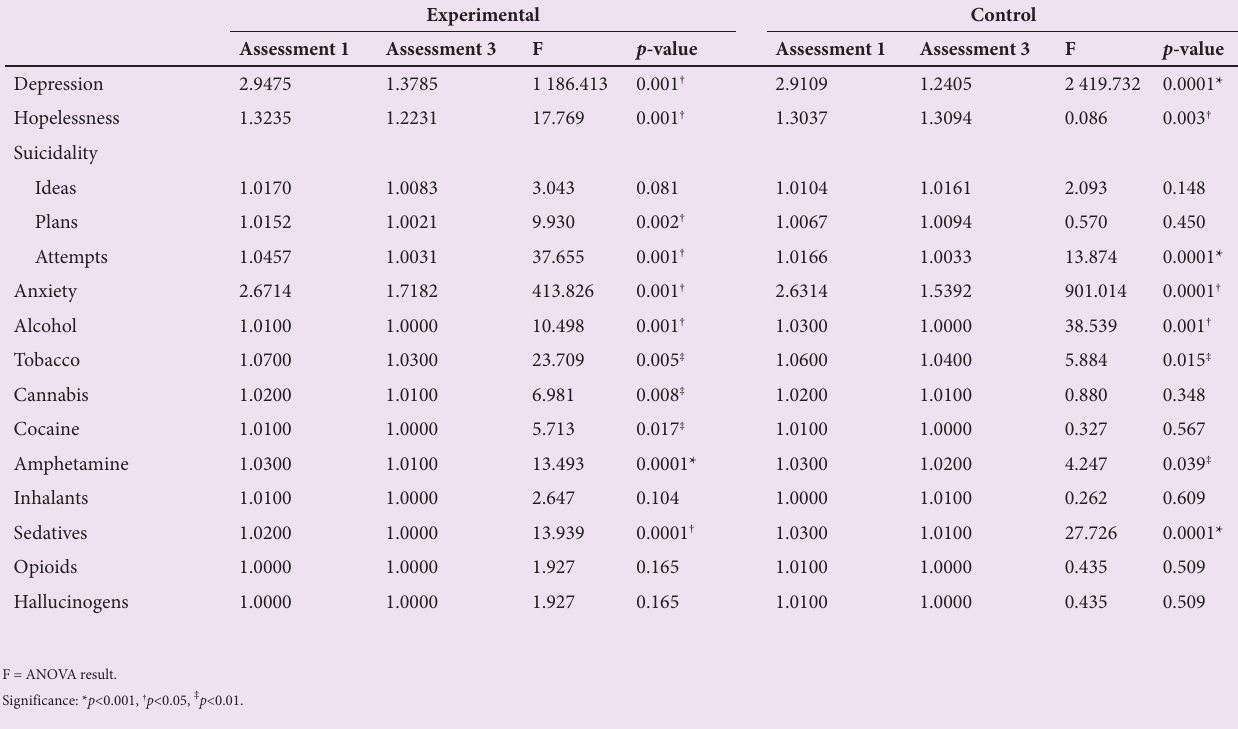
Table 6. Correlation co-efficient test on mean difference of effect of psycho-education between assessments 1 and 3 within each study group